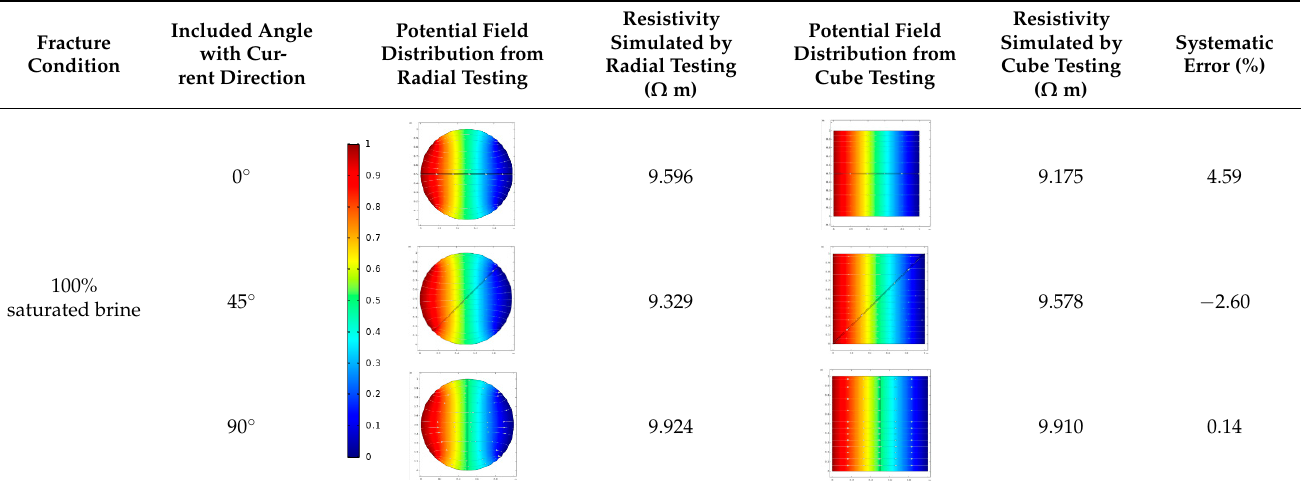
Table 11. Numerical simulation results when fractures are